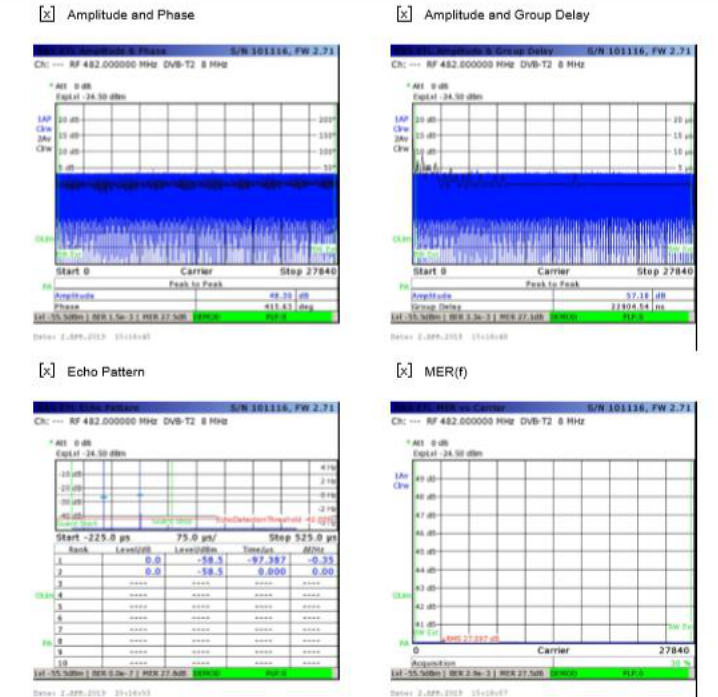
Figure 16. DVB-T2 Signal Form and Values parameters measured in the MFN mode: Level -58.5 dBm; Δ Level, 0 dB; Amplitude 64.86 dB; Phase 1450.54 deg; MER(f); MER (PLP, rms) 27.3 dB; Time offset 100 μs.